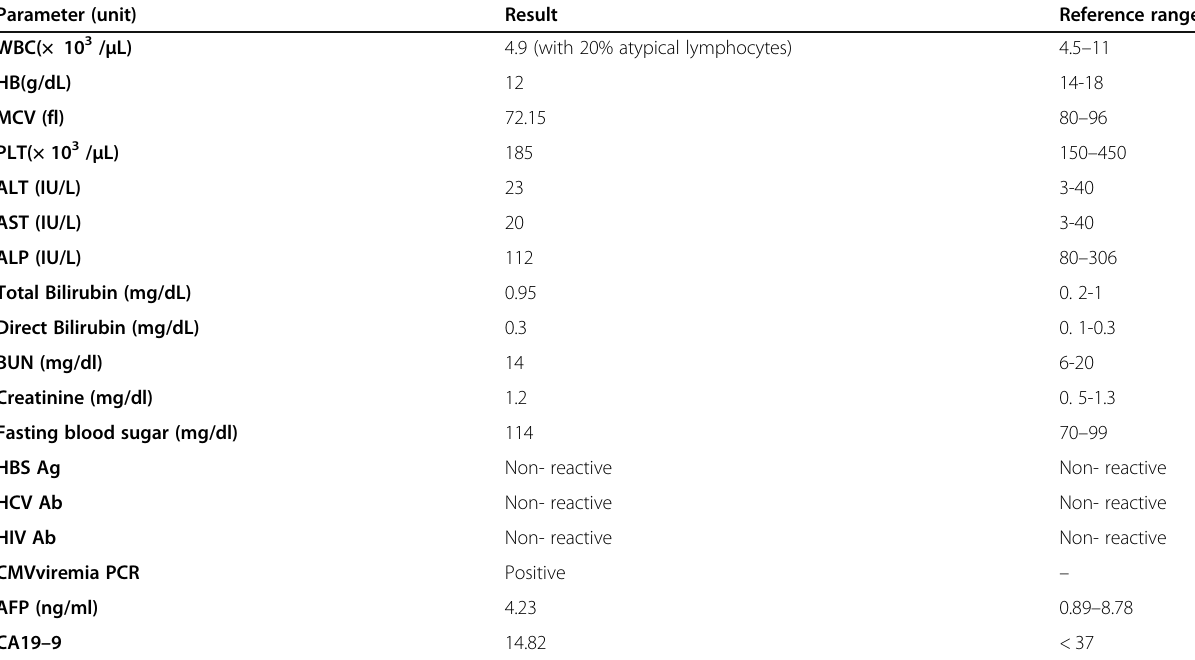
Table 1 The main laboratory data of the patient Parameter